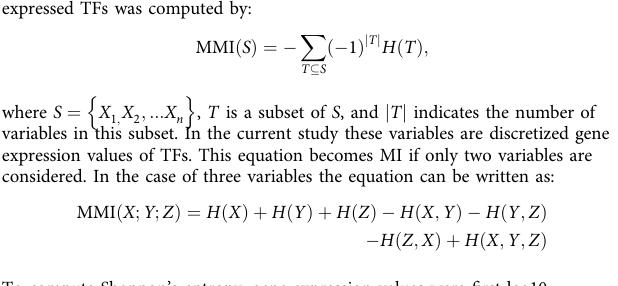
Fig. 3 Conversion of hNES cells into hPRogFPM and their differentiation into midbrain dopaminergic neurons. a Schematic representation of the conversion and differentiation protocols. b , c RT-qPCR analysis at day 8, showing the expression of midbrain-hindbrain TFs, such as OTX2 , GBX2 , LMX1A, and FOXA2 ( b ), as well as the dopaminergic neuron markers, NR4A2 , TH , SLC18A22, and SLC6A3 ( c ). d Immunocytochemistry analysis of the presence of OTX2 and TH in control unconverted NES cultures, compared with NES cells converted with SAF + Dkk1 and differentiated until day 8. e , f Percentage of OTX2 + and TH + cells in the conditions in d . P = 0.02673 ( e ), P = 0.03233 ( f ), n = 3. g – i Expression of the key midbrain TFs, LMX1A, NR4A2, and PBX1, in TH + cells derived from SAI2-NES cells after conversion and differentiation. j, k TH + cells express the mature neuronal marker, MAP2 ( j ), and some acquire mature